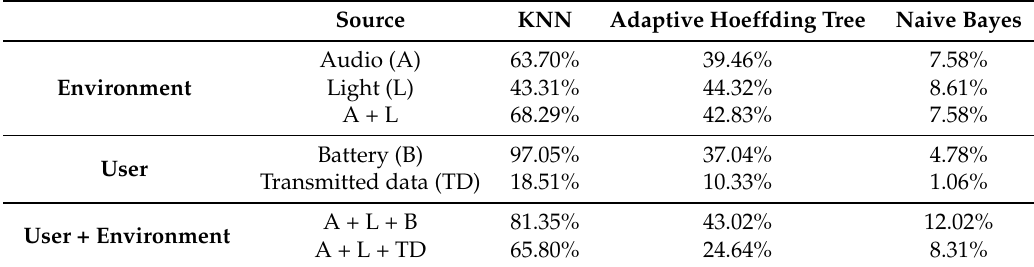
Table 4. Accuracy